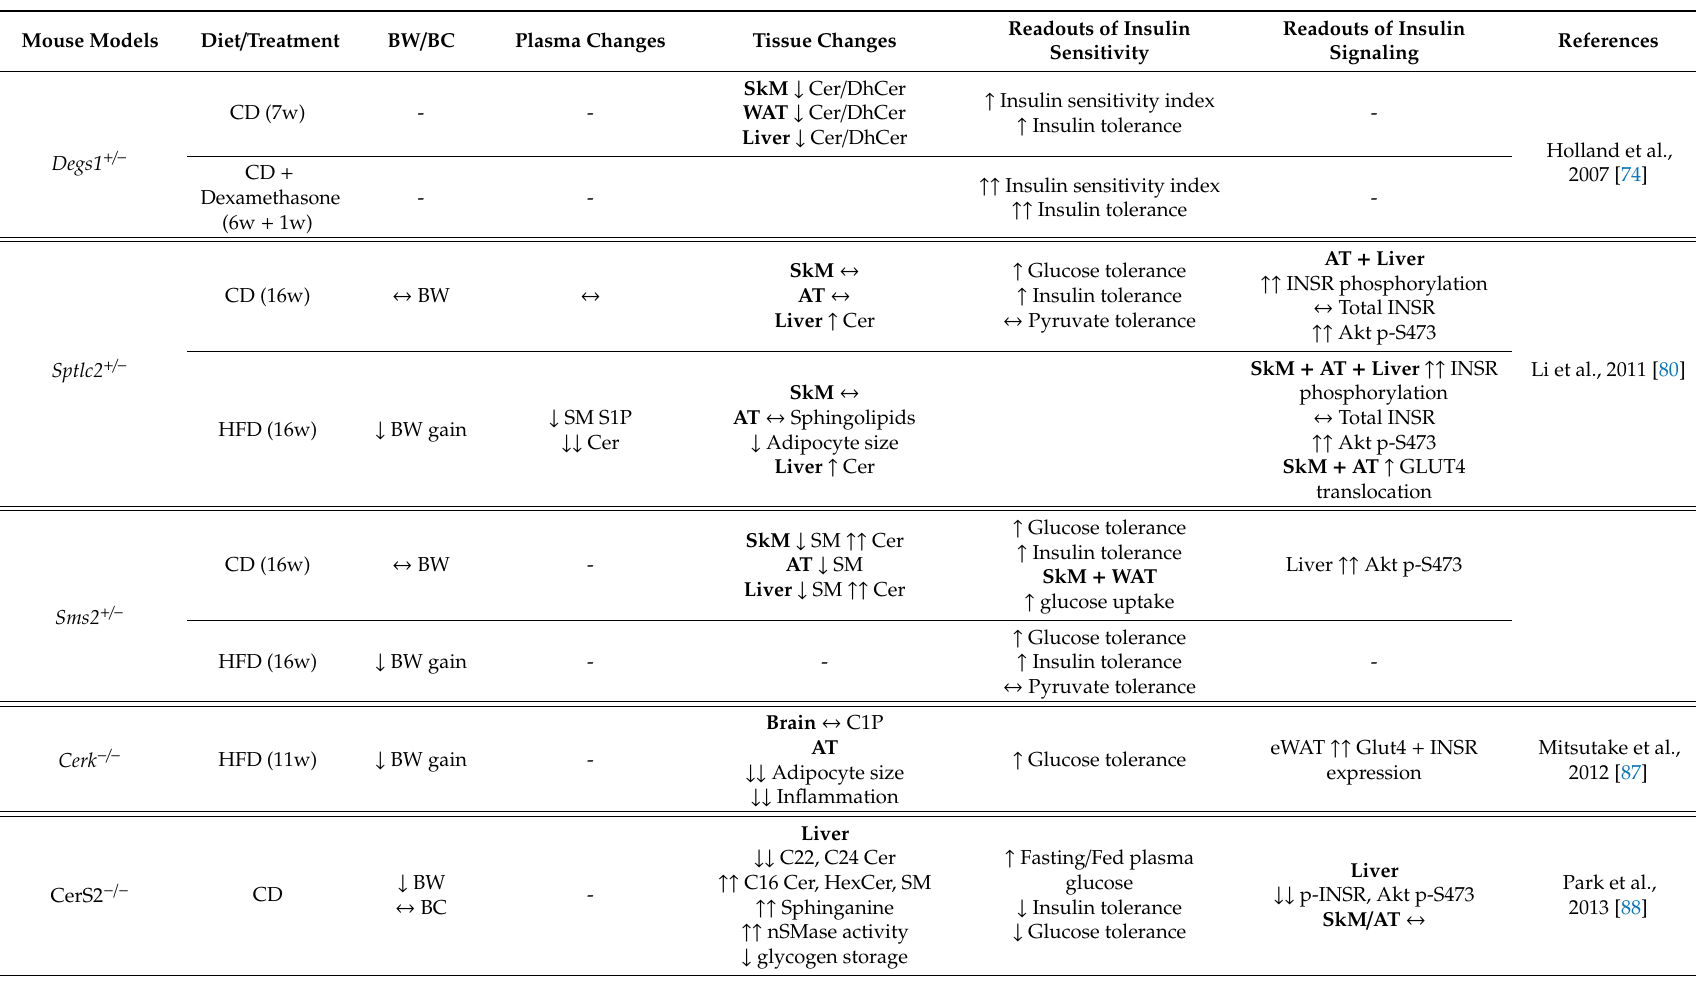
Table 1. Transgenic mouse models of whole-body and tissue-specific modulation of total and species-specific ceramide and sphingolipid